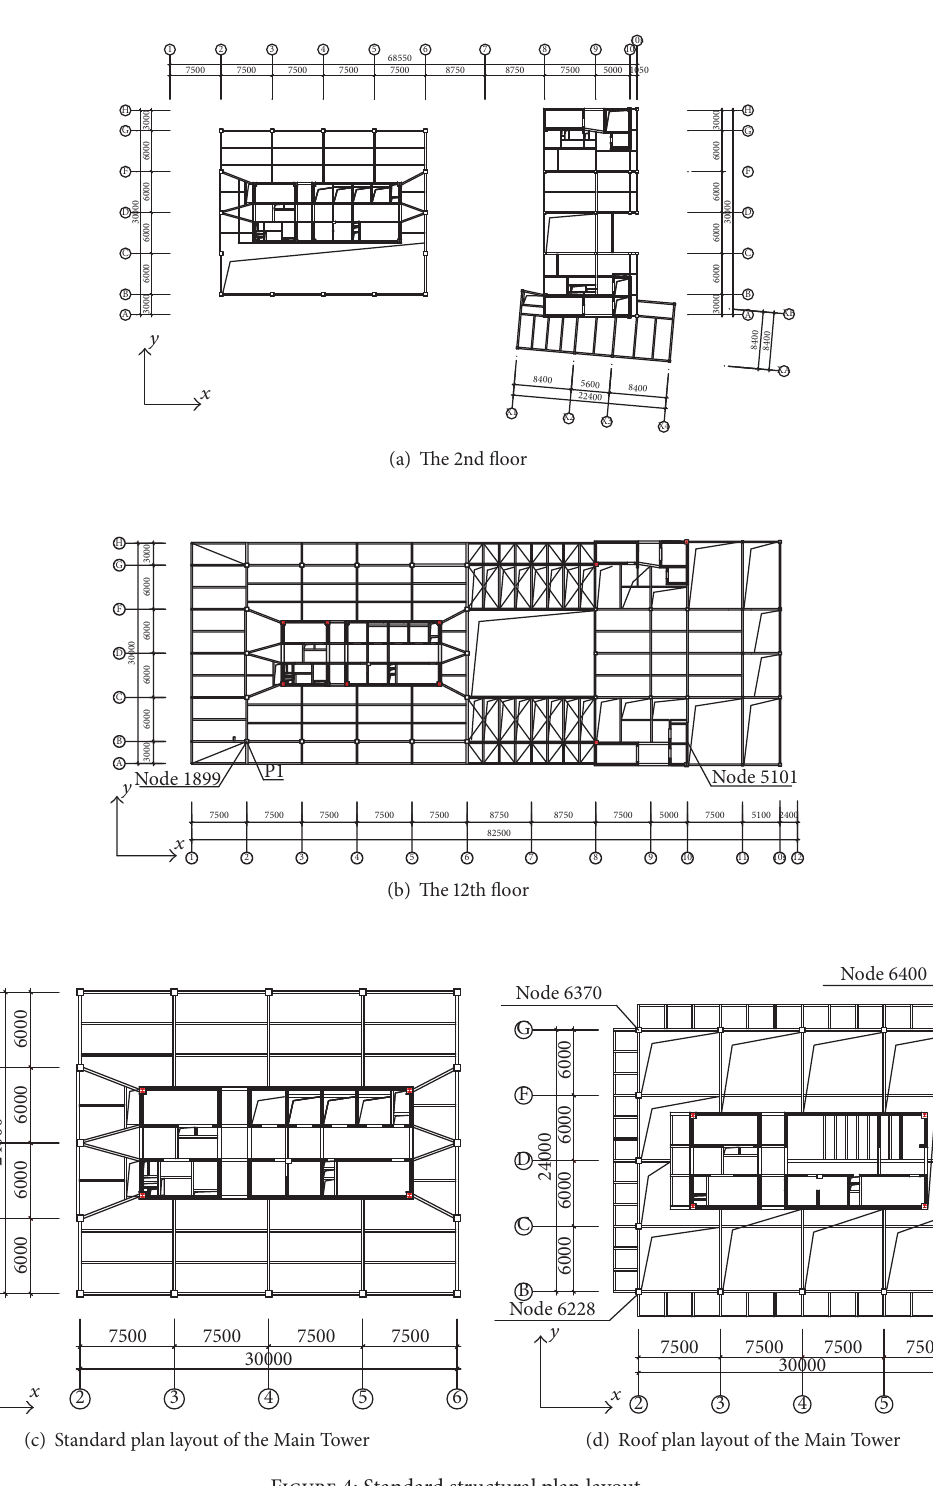
Figure 4: Standard structural plan